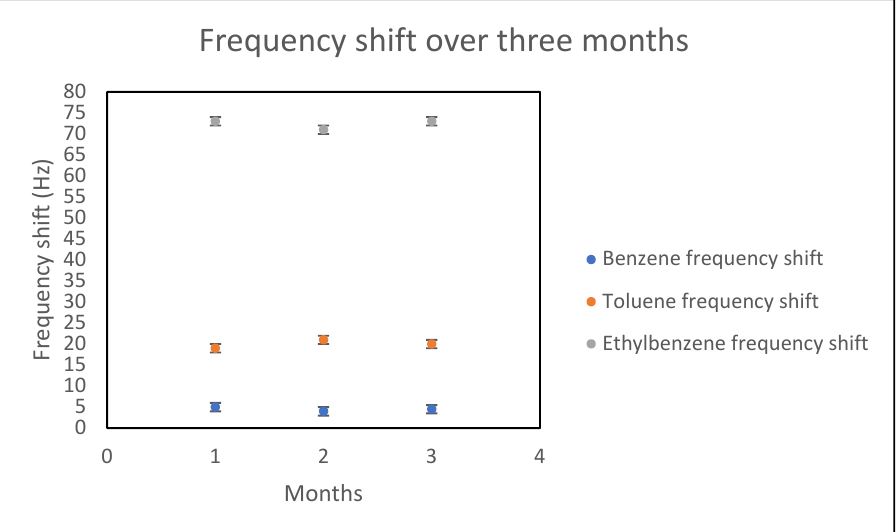
Figure 7. Frequency shifts for benzene, toluene and ethylbenzene in PS–BS (15%) film over three